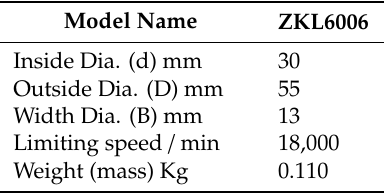
Table 1. Specifications of roller element ball bearing.